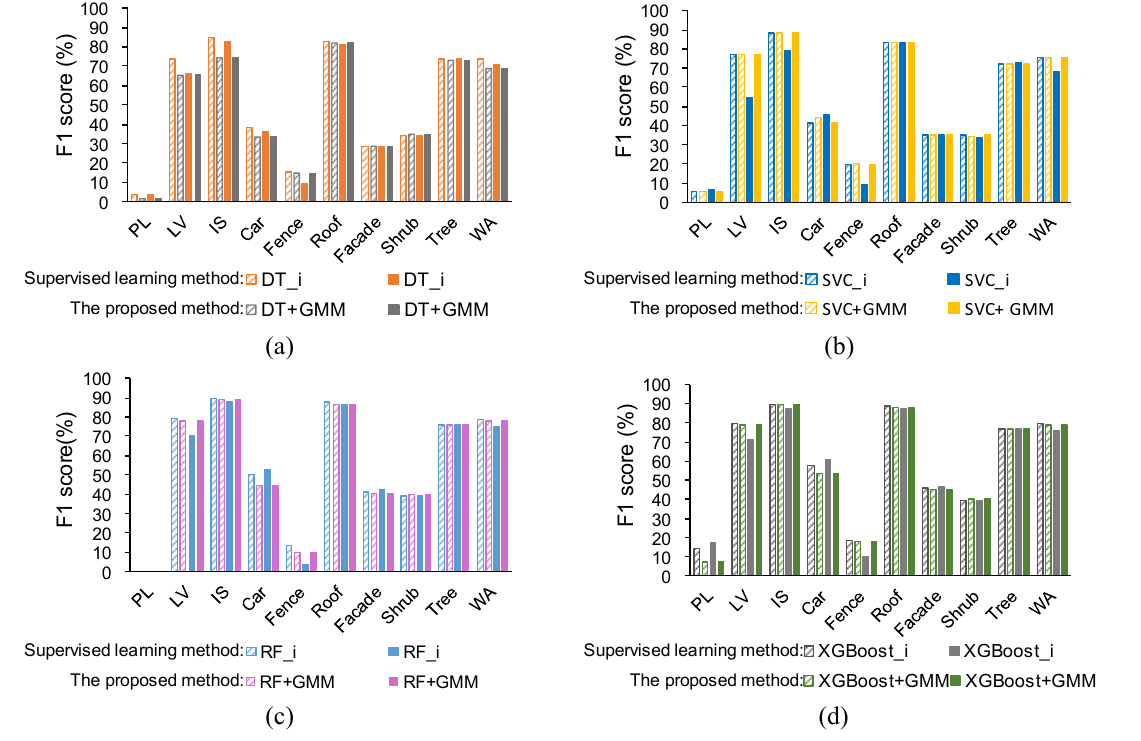
Figure 10. Comparison between supervised learning methods considering intensity and the proposed method under two conditions: same condition was filled with colored slashes, and different condition was filled with solid colors. WA is an abbreviation for weighted average of all classes. The supervised method in ( a ), ( b ), ( c ), ( d ) is DT, SVC, RF and XGboost, respectively.